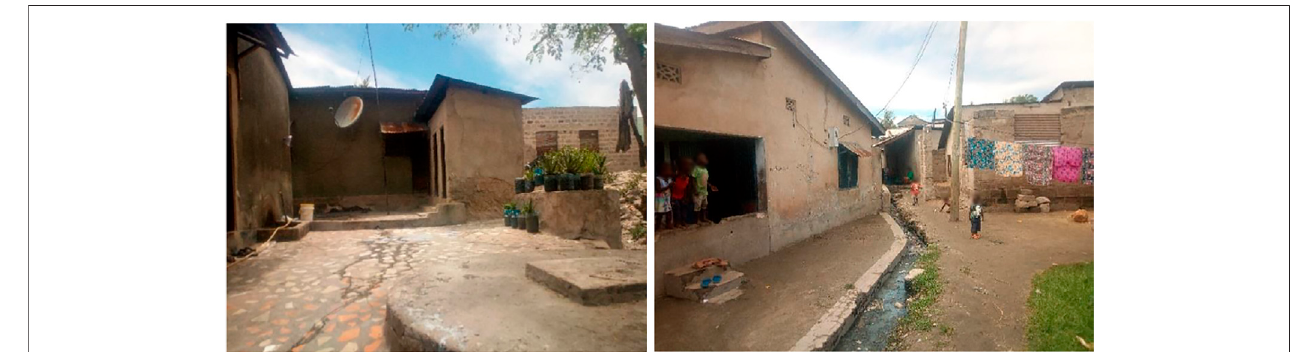
FIGURE 3 | Swahili house — typical layout of buildings in Keko Machungwa. Source: Mbuya, 2017.